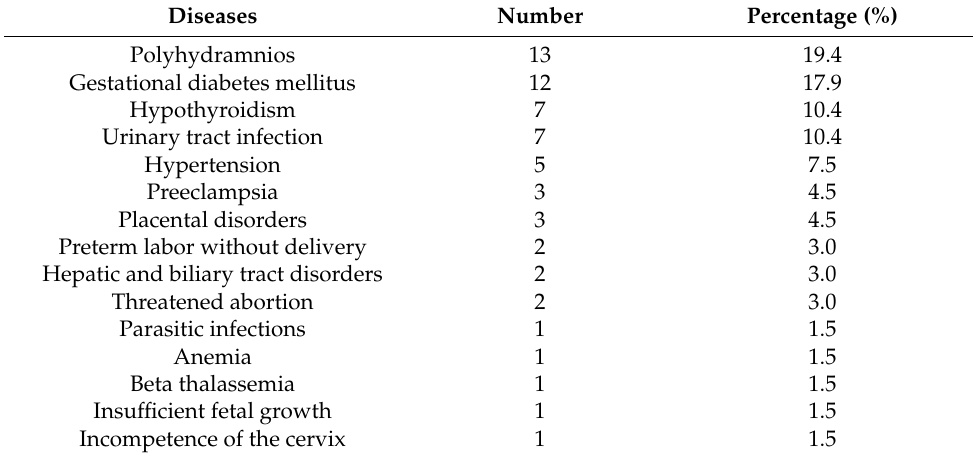
Table 6. Distribution of gestational diseases of the pregnant women of cases with oesophageal atresia during the period 2007–2019 in the Valencian